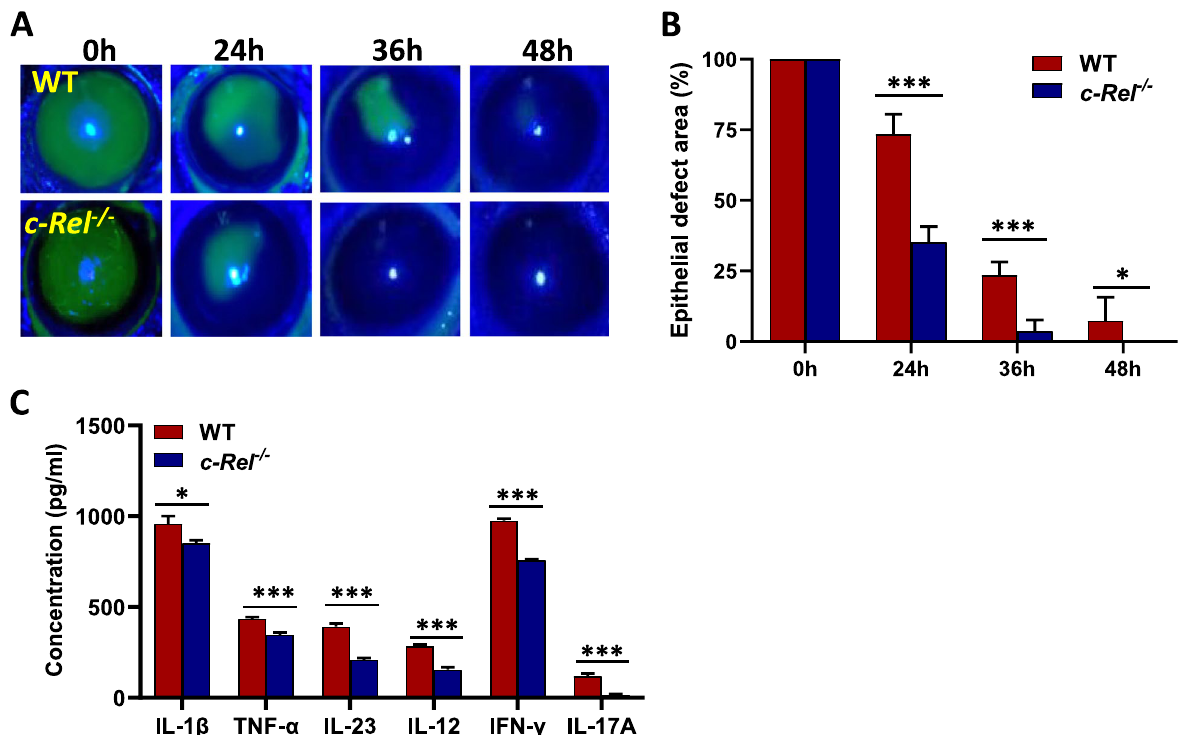
Fig. 2 c-Rel-deficient mice exhibit accelerated corneal wound healing and reduced inflammatory cytokine production. The corneal epithelial wound healing model was established in both wild-type ( n 8) and c-Rel-deficient mice ( c-Rel −/− ) ( n 8) as described in the “Materials and = = methods” section. A Corneal epithelial wounds were stained with fluorescein sodium and examined under slit lamp microscope at the indicated time points. B Statistical analysis of corneal epithelial defect area using Image J software. C Corneal tissue extracts were prepared at 24 h after corneal epithelial scraping and the production of inflammatory cytokines as indicated in the figure was determined by ELISA. For A and C , results shown are representative of two independent experiments. For B , results shown are combined from two independent experiments. * P <0.05, *** P